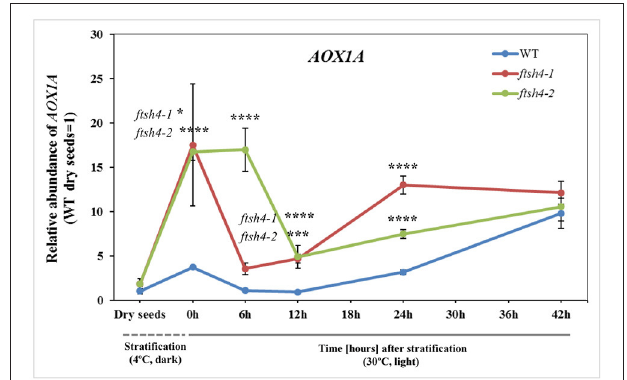
FIGURE 10 | Abundance of AOX1A at the transcript level in dry, stratified and germinating wild-type and ftsh4 seeds. Transcript abundance was quantified with qRT-PCR. The values are given as relative to the value obtained for WT dry seeds (set as 1). Data are mean ± SD of at least four independent biological replicates. * p ≤ 0.05; *** p ≤ 0.001; **** p ≤ 0.0001.